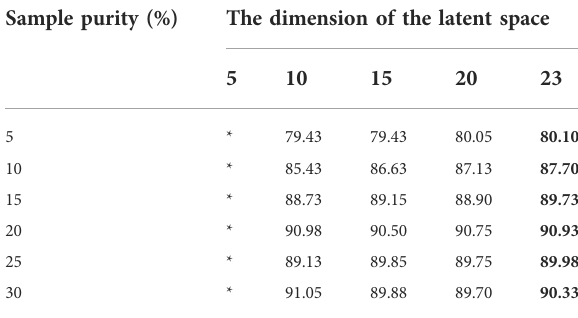
The best results are highlighted in